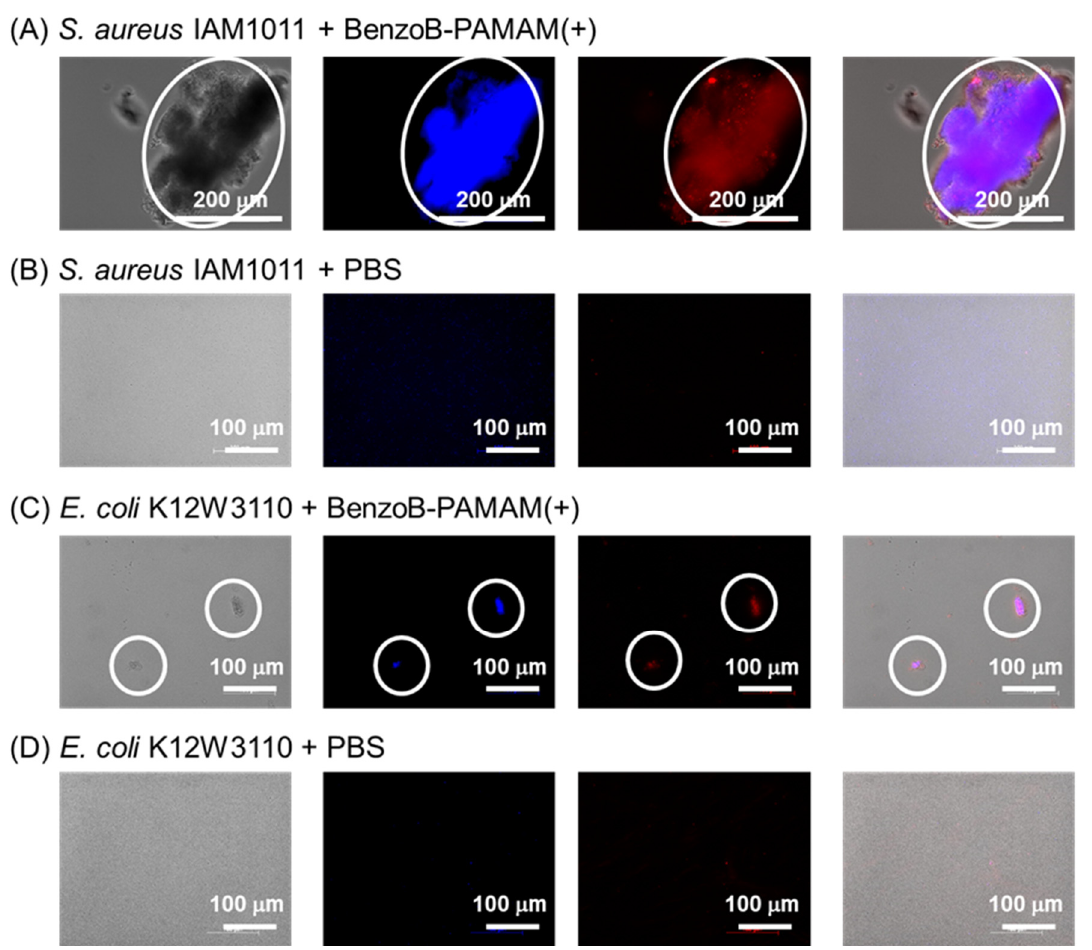
Figure 6. Microscope observation of S. aureus IAM1011 and E. coli K12W3110 at a pH of 7.4, adjusted with PBS. [BenzoB-PAMAM(+)] = 3.3 × 10 − 6 M or none; bacterial concentration was set at 2.3 × 10 8 CFU·mL − 1 for S. aureus IAM1011 and 5.0 × 10 8 CFU·mL − 1 for E. coli K12W3110. From left to right: DIC, DAPI, PI, and merged microscopy images. Scale bar = 200 μ m in ( A ) and 100 μ m in ( B ) − ( D ).